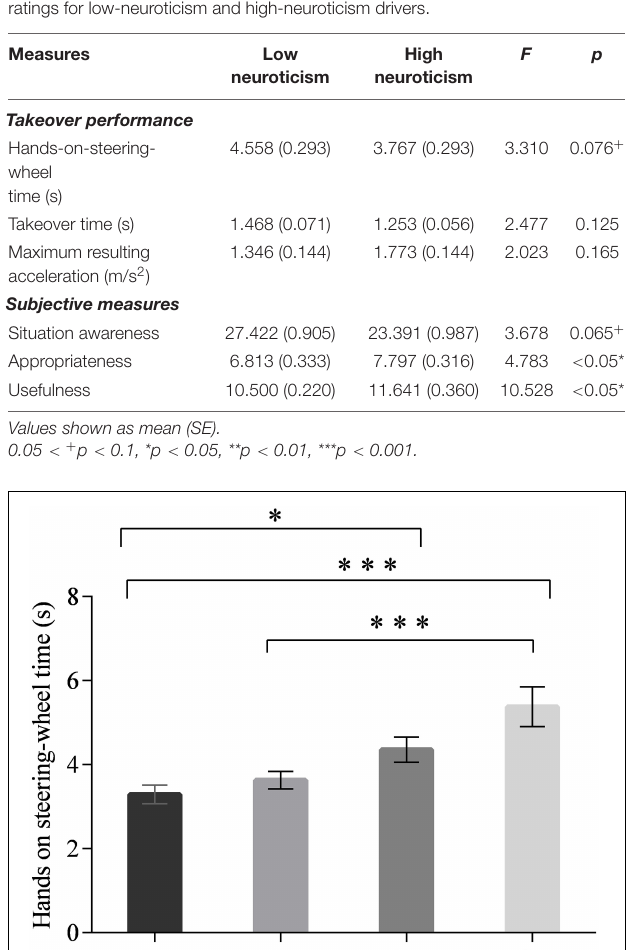
Maximum Resulting Acceleration No main significant effect of time interval [ F ( 3 , 90 ) = 0.340, p = 0.797] or neuroticism [ F ( 1 , 30 ) = 2.023, p = 0.165] or the interaction effect of two factors [ F ( 3 , 90 ) = 0.167, p = 0.918] was observed on maximum resulting